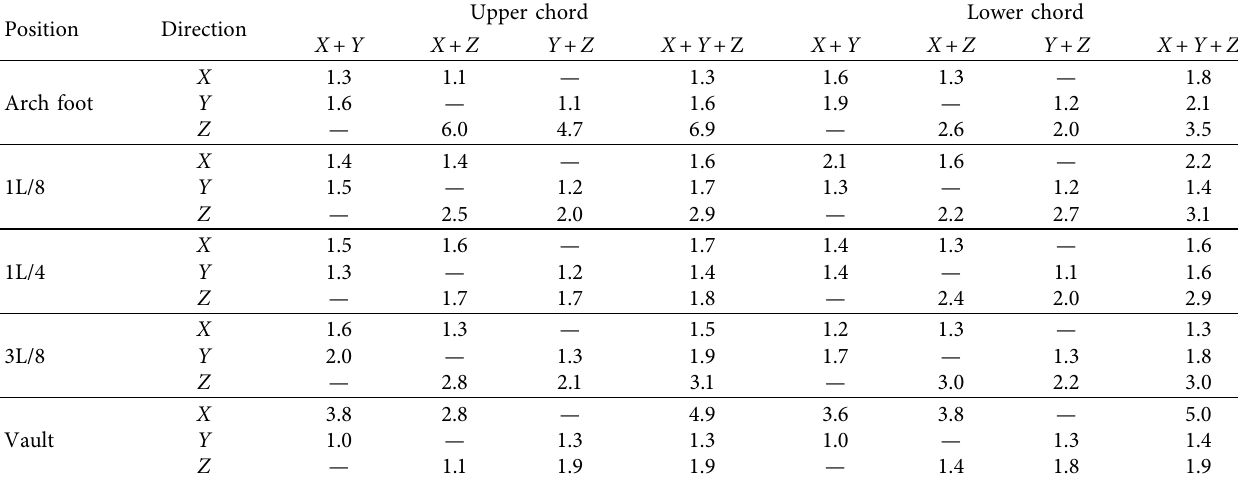
Table 3: Chord axial force ratio table of two dimensions than one dimension.